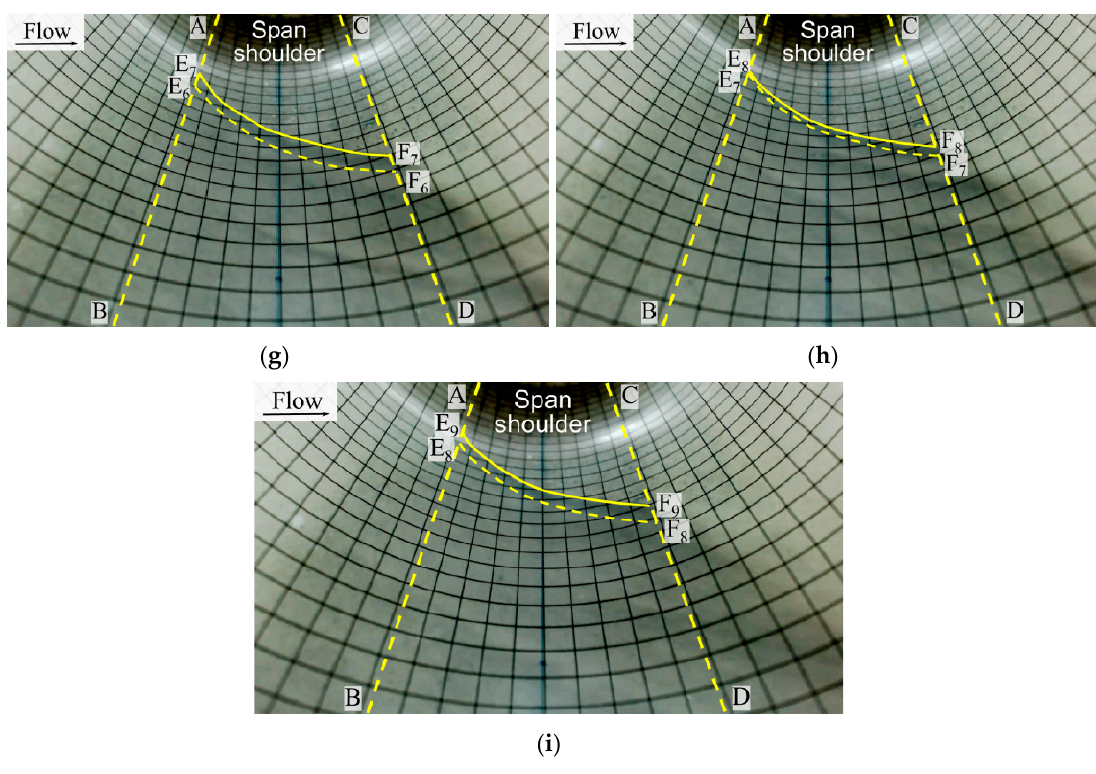
Figure 4. Video frames of the initial scour process: ( a ) t = 29.713 s; ( b ) t = 33.281 s; ( c ) t = 37.504 s; ( d ) t = 43.713 s; ( e ) t = 46.816 s; ( f ) t = 50.480 s; ( g ) t = 52.816 s; ( h ) t = 53.904 s; ( i ) t = 55.072 s.